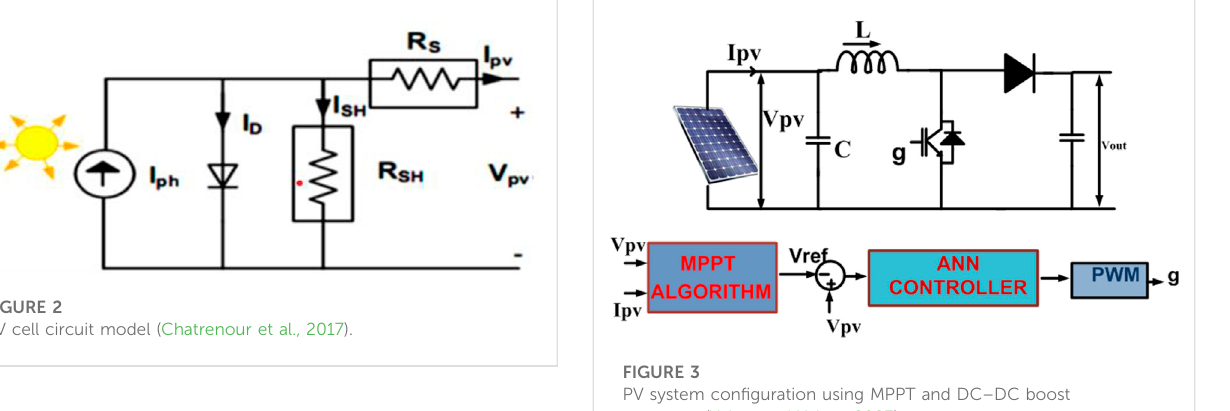
FIGURE 3 PV system con fi guration using MPPT and DC – DC boost converter (Yahya and Yahya, 2023).